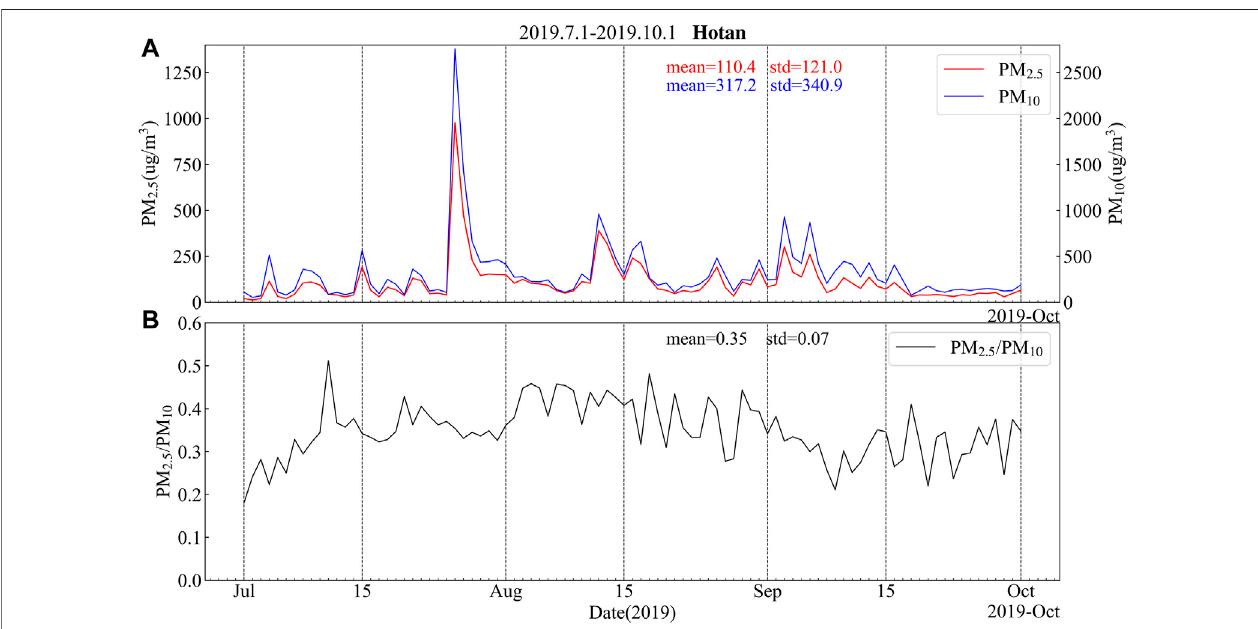
FIGURE2| Timeseriesofhourlymeanmassconcentrationsofparticulatematter(PM)atHotanfromJuly1toSeptember30,2019. (A) PM 2.5 ( μ g/m 3 ) vs .PM 10 ( μ g/ m 3 ). (B) Ratios of PM 2.5 /PM 10 . The corresponding total mean values and standard deviation are shown in the fi gures.